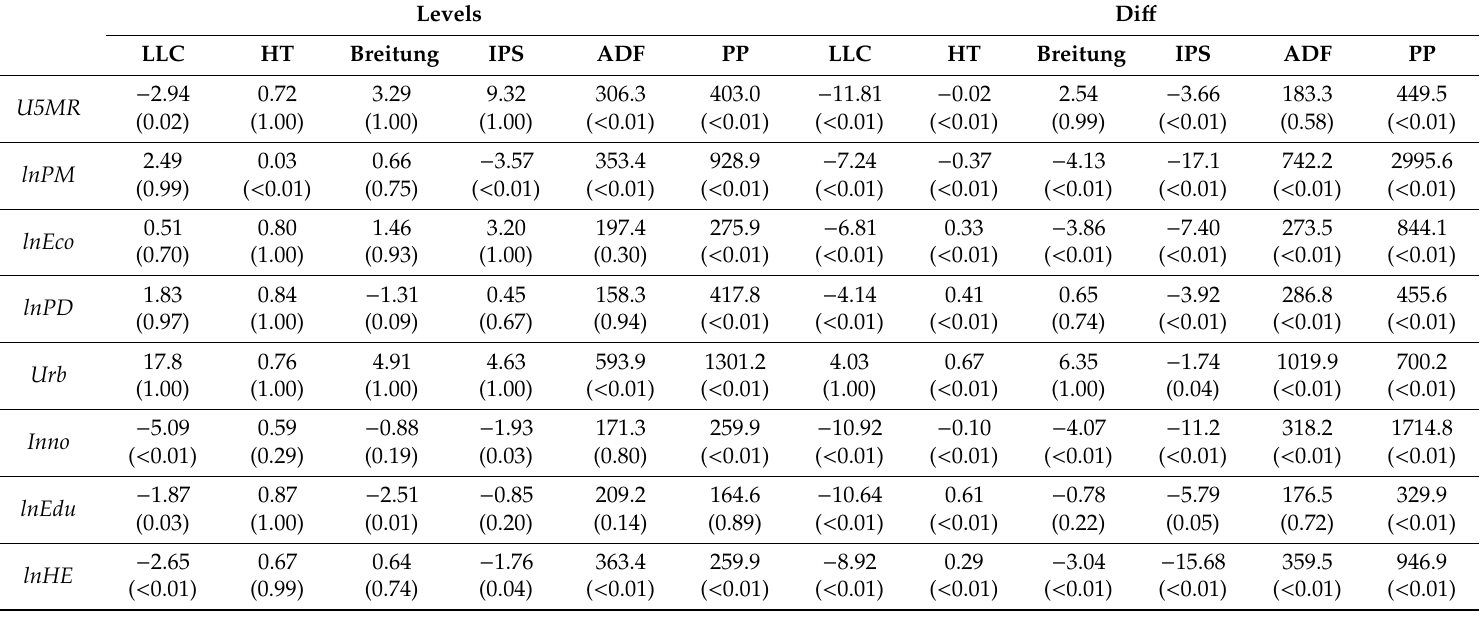
Table 2. Results of panel unit root